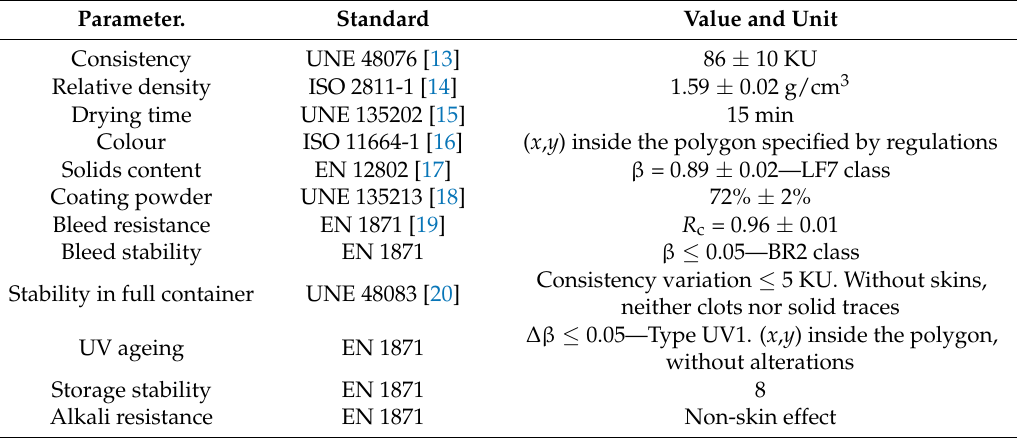
Table 3. White styrene acrylic painting specifications.